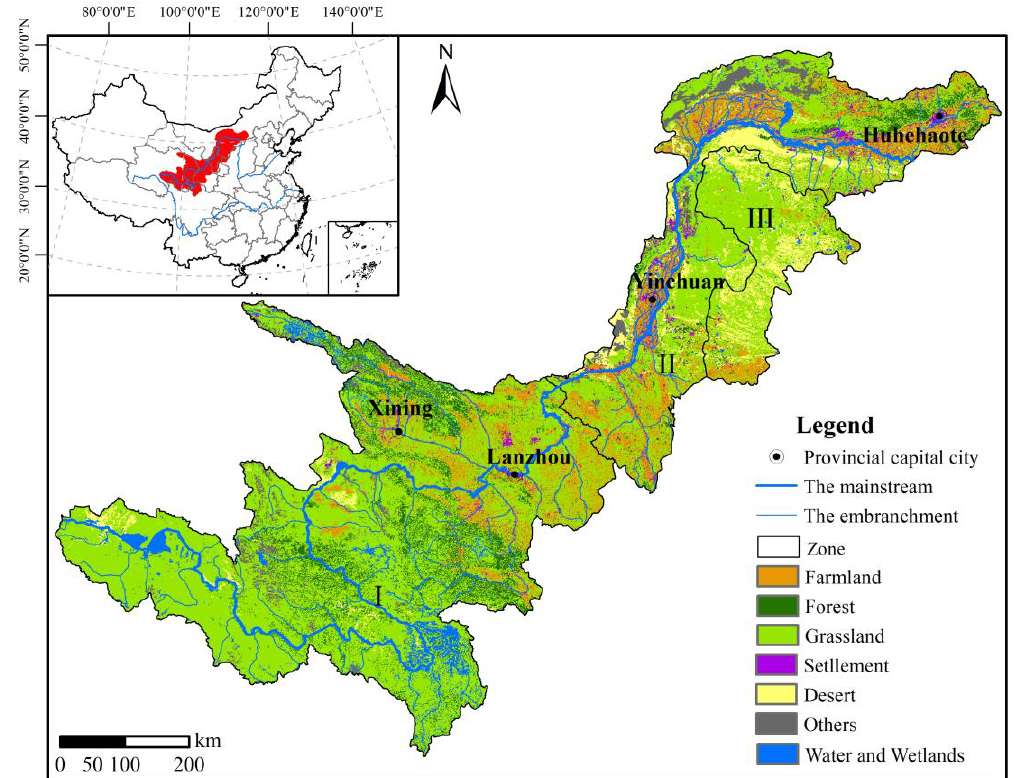
Figure 1. Spatial distribution of the ecosystem macrostructure in the Upper Yellow River region in 2018. (I) the upper section of the Upper Yellow River; (II) the lower section of the Upper Yellow River; (III) the inner flow area of the Upper Yellow River.